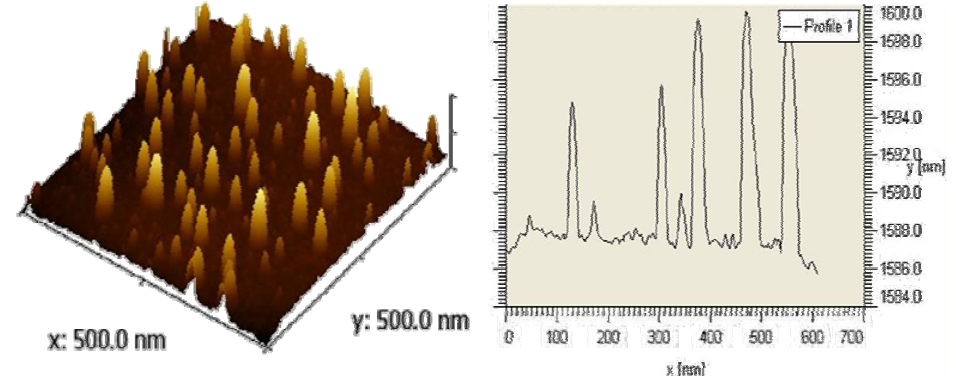
Figure 3. Atomic Force Microscopy (AFM) picture and profile of the deposit of compound 2 on Au(111) [21].